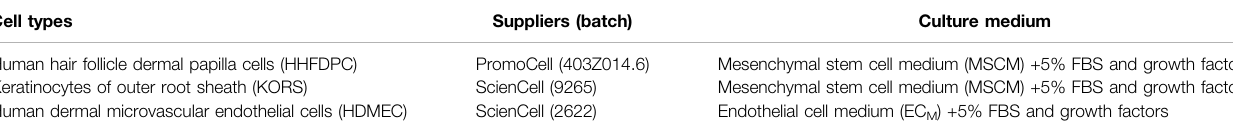
TABLE 1 | Cell types used. Cell types Suppliers